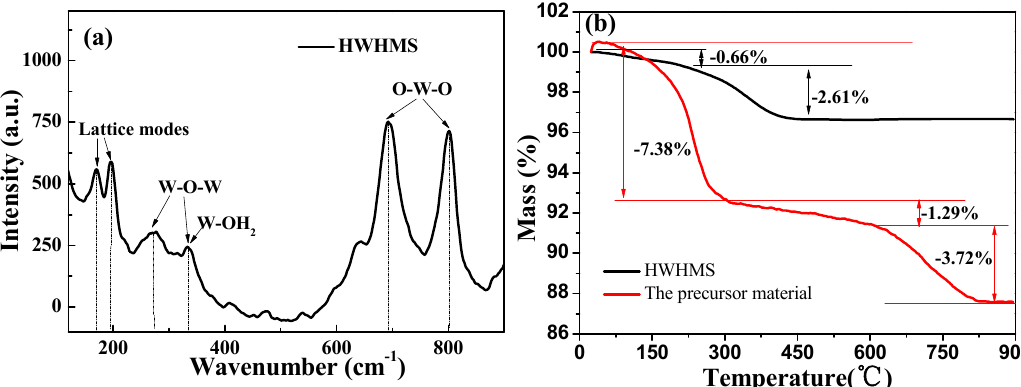
Figure 3. ( a ) Raman spectrum of HWHMS; ( b ) TG curve of HWHMS and the precursor material. The thermal stability and chemical components were investigated by TGA (Figure